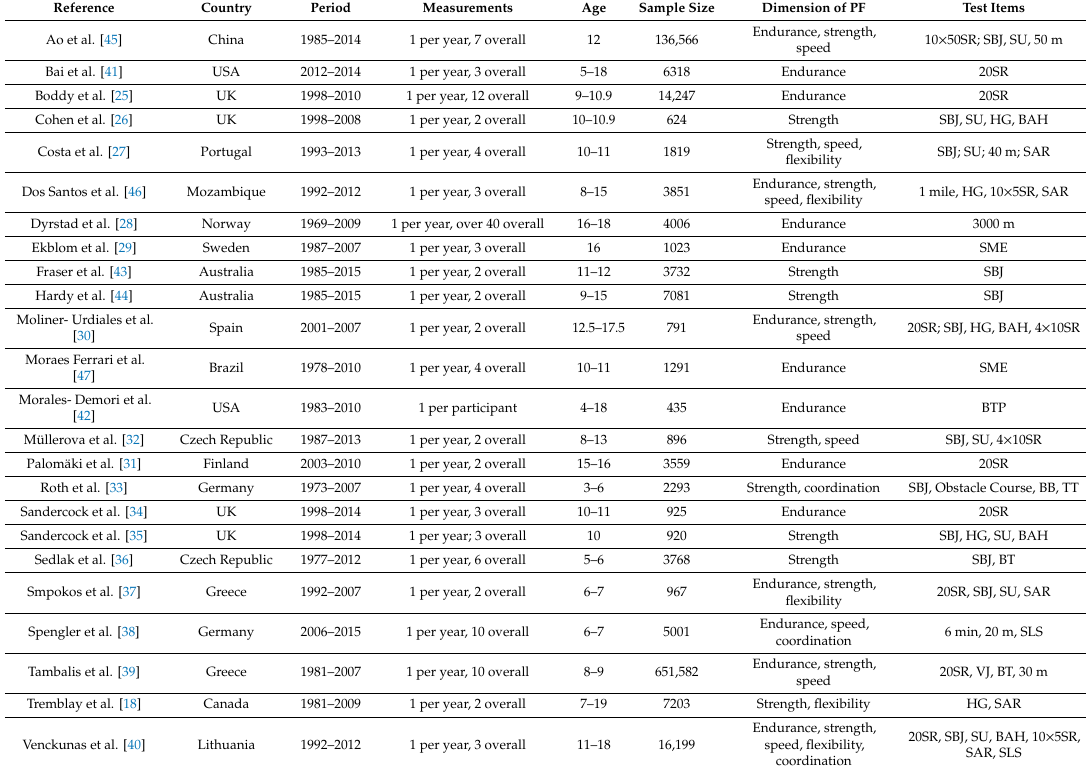
20SR,SBJ,SU,BAH,10 × 5SR,